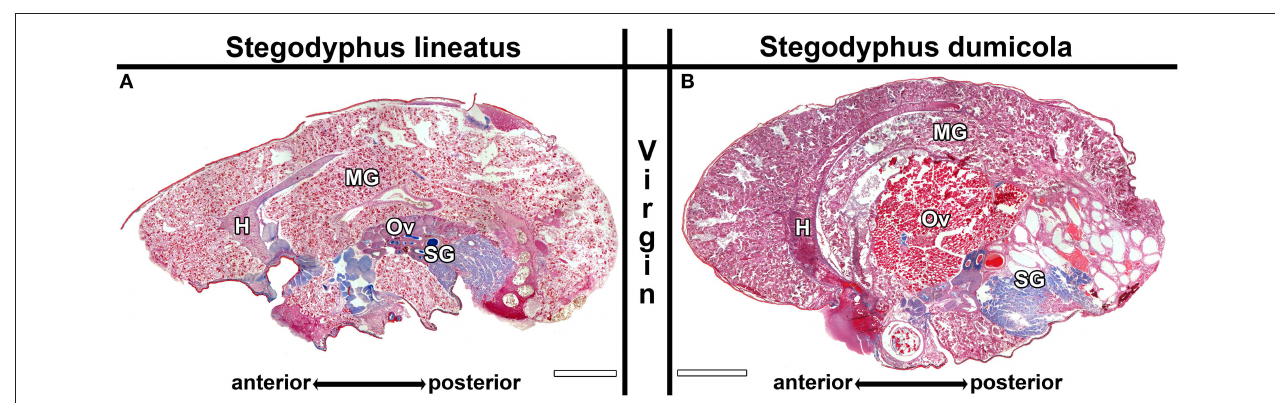
FIGURE 5 | Midgut sections of virgin control females of Stegodyphus lineatus (A) and S. dumicola (B) sampled at the beginning of the experimental period. The midgut tissue (MG) consists of diverticula embedded in storage tissue and surrounds the heart (H), reproductive organs (Ov) and the silk glands (SG). No blue stained secretion granules or extracellular materials are visible. The ovary of S. lineatus contains exclusively pre-vitellogenic oocytes while the ovary from S. dumicola shows far matured oocytes. Virgin Controls sampled at the end of the experimental period did not differ. Scale bars are 2,000 µ m.